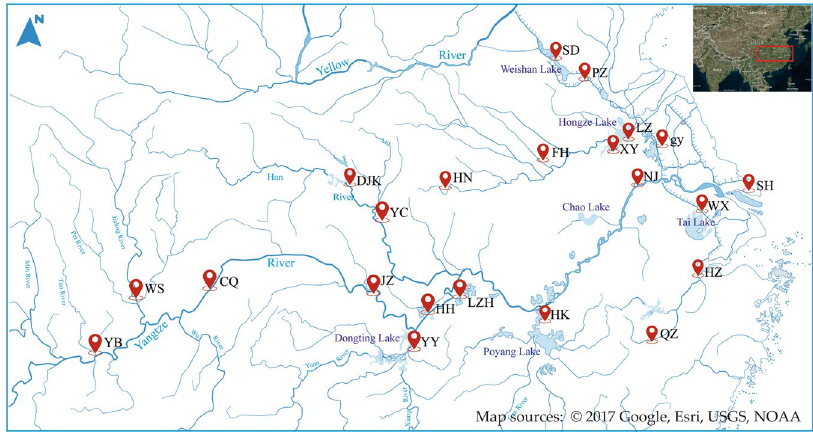
Figure 6. Geographic locations of 22 P. clarkii populations collected for 2b-RAD in China. The map was generated using ArcGIS